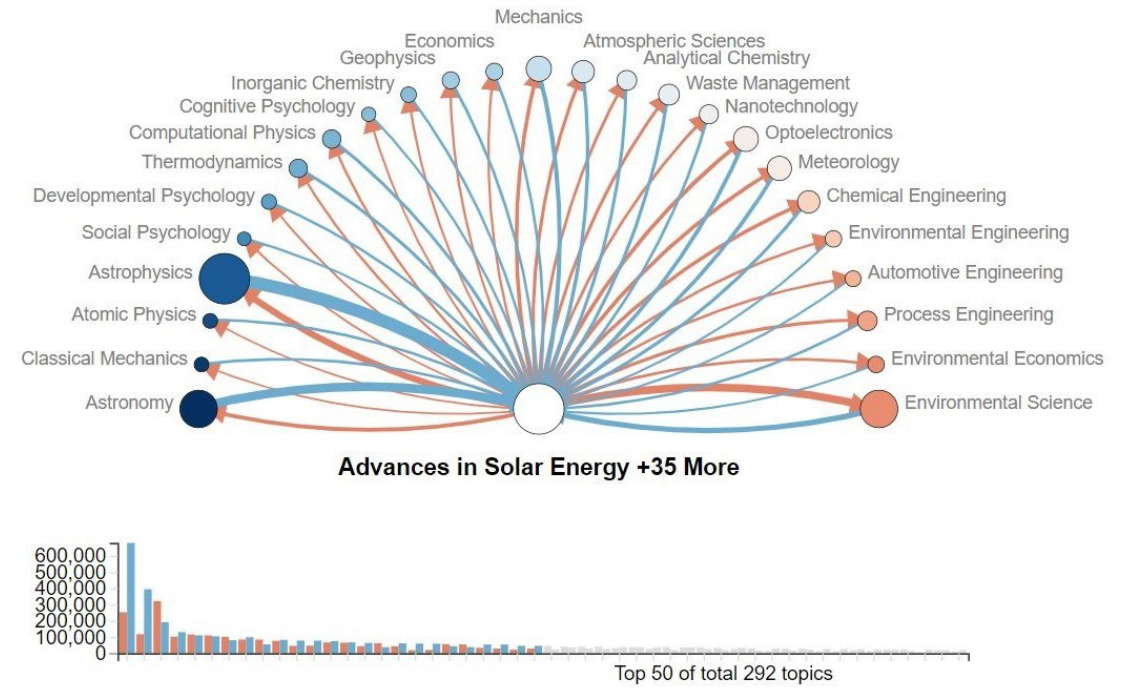
Figure 9. Influence flower visualizes publications and citations connections between research